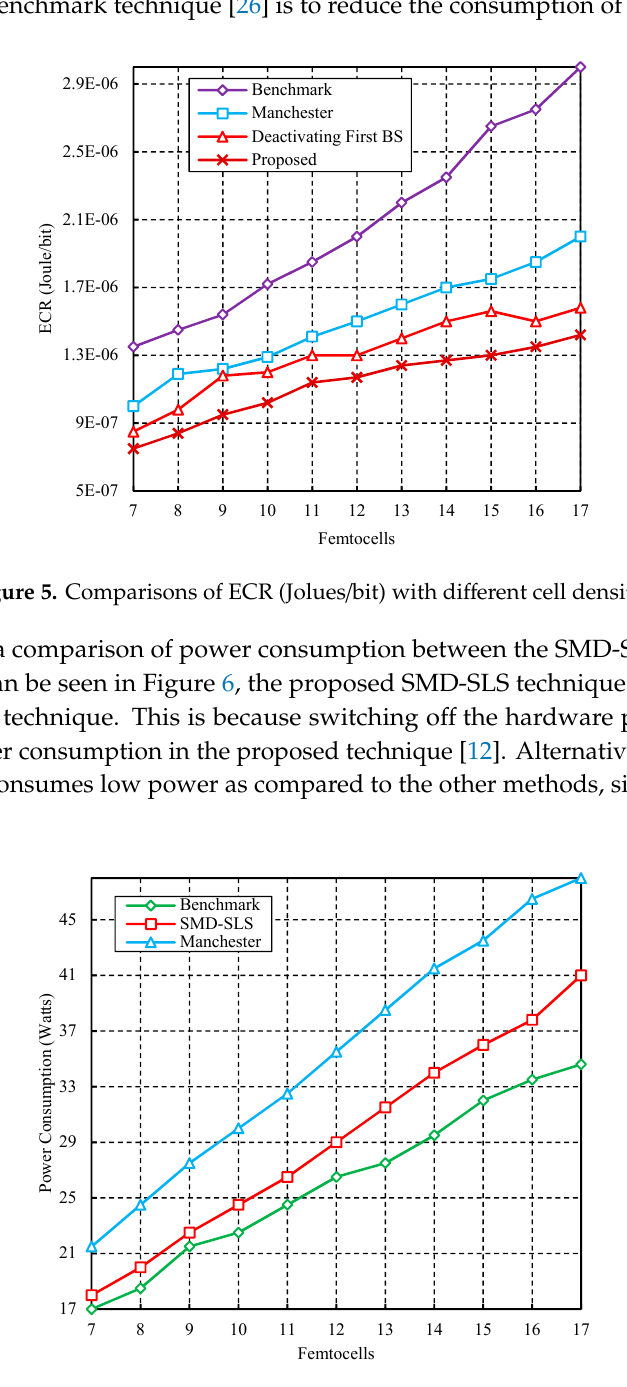
Figure 6. Comparisons of power consumption for different cell densities.